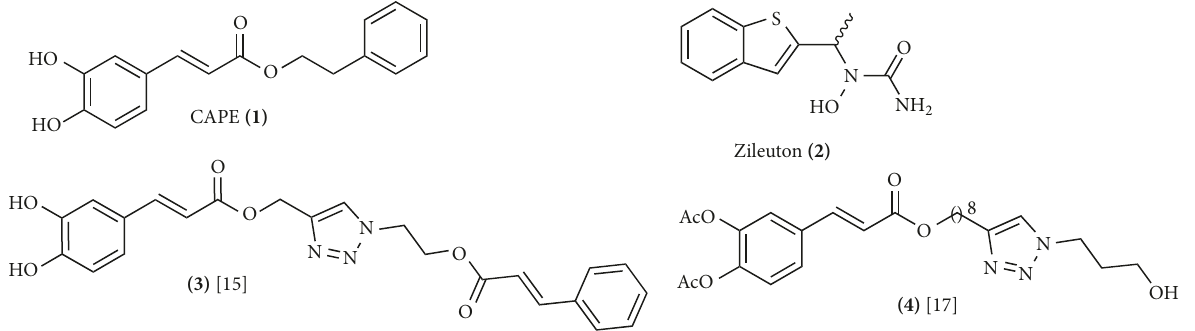
Figure 1: Structures of CAPE ( 1 ), Zileuton ( 2 ), compound ( 3 ) [15], and compound 4 [13].